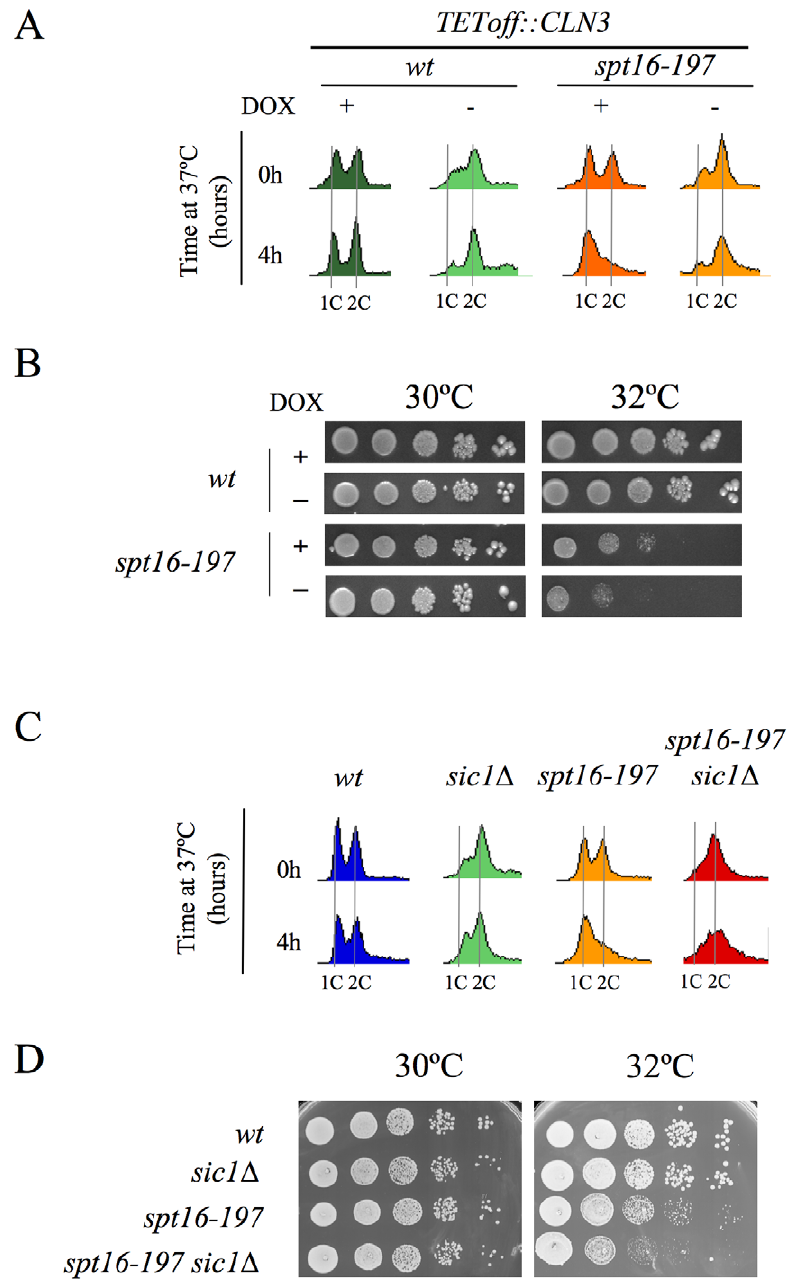
Figure 3. The forced entry of Spt16-deficient cells into the S-phase lowered their viability. (A) Wild-type (FY120) and spt16-197 (FY348) cells, containing the centromeric pTet off -CLN3-HA plasmid, were grown in a synthetic medium (SC without uracil) at 30 u C in the presence ( + ) or absence ( 2 ) of doxycycline (5 m g/ml). Exponentially growing cells were then transferred to 37 u C for four hours and analyzed by flow cytometry. (B) The wild-type and spt16-197 cells containing the pTet off -CLN3-HA plasmid were grown until the mid-log phase in a synthetic medium (SC-URA) at 30 u C in the presence ( + ) or absence ( 2 ) of doxycycline. Then, 10-fold serial dilutions were spotted onto the same media and incubated at the permissive (30 u C) or semi-permissive (32 u C) temperature. The first spot on the left corresponds to 5 m l of the undiluted culture. Pictures correspond to three days of incubation. No growth was detected on the forth spot of spt16-197 minus doxycycline at 32 u C, even after five days of incubation. (C) The wild-type (MMY18.10), sic1 D (MMY18.12), spt16-197 (MMY18.11) and spt16-19 sic1 D (MMY18.9) cells growing exponentially in YPD at 30 u C were shifted to 37 u C for four hours. Cells were then analyzed by flow cytometry. (D) The exponentially growing cells from the strains mentioned in (C) were spotted onto YPD plates, as described in (B), and incubated at 30 u C and 32 u C as indicated. Pictures correspond to three days of incubation. No growth was detected on the fifth spot of the double mutant at 32 u C, even after five days of incubation. doi:10.1371/journal.pgen.1000964.g003 The results show a more marked reduction of CLN3 mRNA after do this, we pre-synchronized the spt16-197 rad53K227A cells with one hour at 32 u C in the double spt16-197 rad53K227A mutant than alpha-factor and analyzed the CLN3 mRNA levels one hour after in the single spt16-197 mutant (Figure 6C). Therefore, the absence switching them to 32 u C in the continued presence of pheromone.